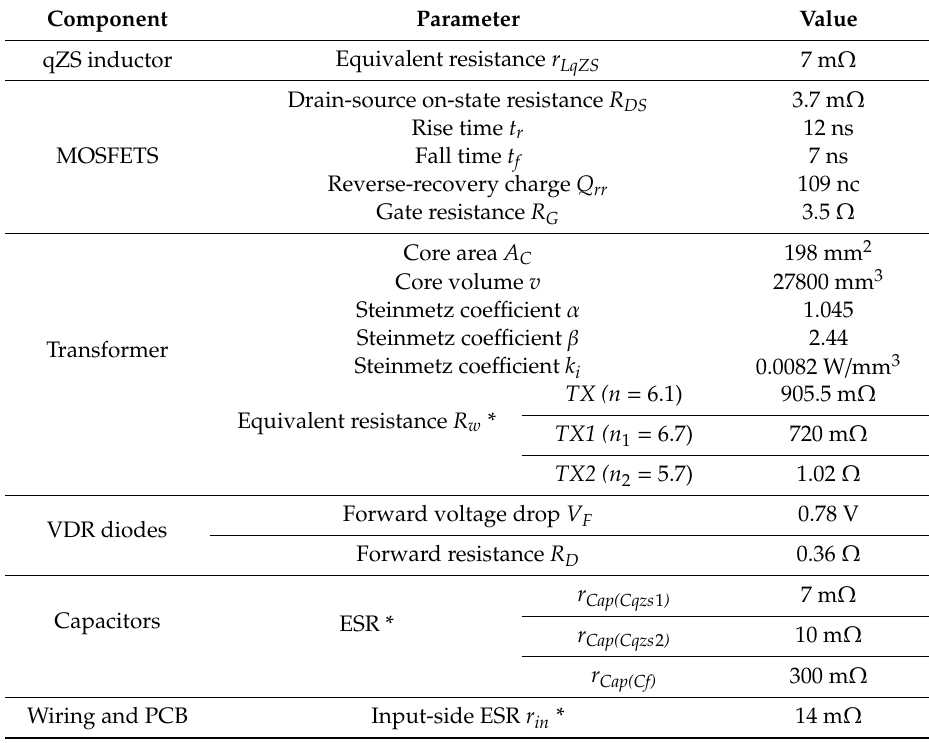
Table 3. Values used for estimation of power